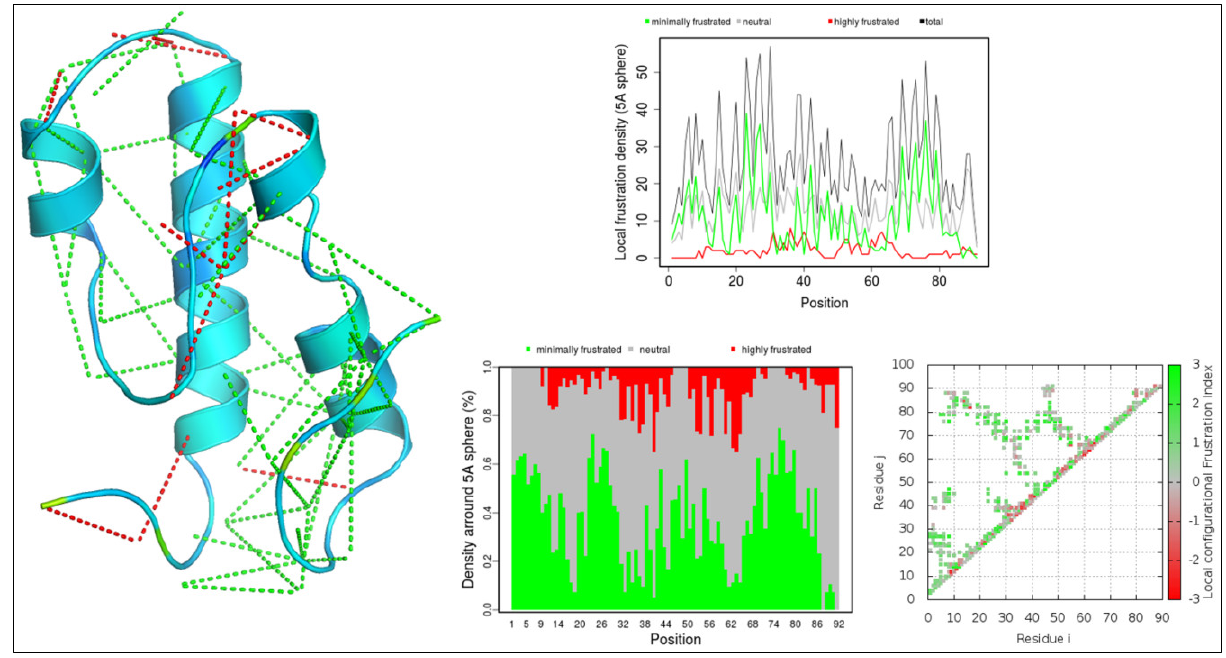
Figure 6. Aligning the before and after molecular dynamics-simulated structures of DLC1. There were a few regions in the refined structure that did not align perfectly with the original DLC1 protein.